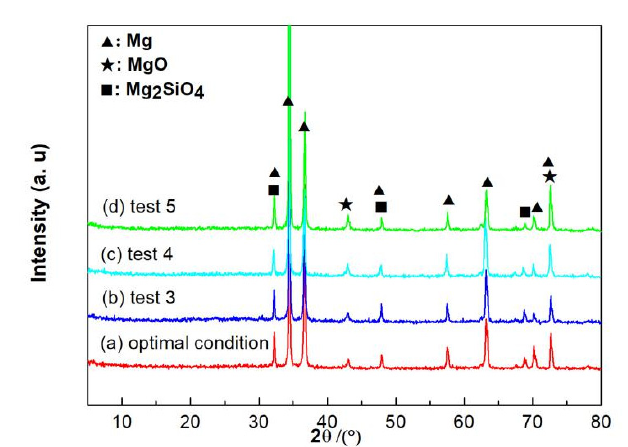
Figure 8. XRD patterns of PEO coatings ( a ) optimal condition, ( b ) test 3, ( c ) test 4 and ( d ) test 5. Optimal conditions are: electrolyte compositions of 45 g/L NaOH, 50 g/L Na 2 SiO 3 and 90 g/L Na 2 B 4 O 7 with electric parameters of current density 1 A/dm 2 ; pulse frequency 200 Hz; duty cycle 10% and oxidation time 15 min.